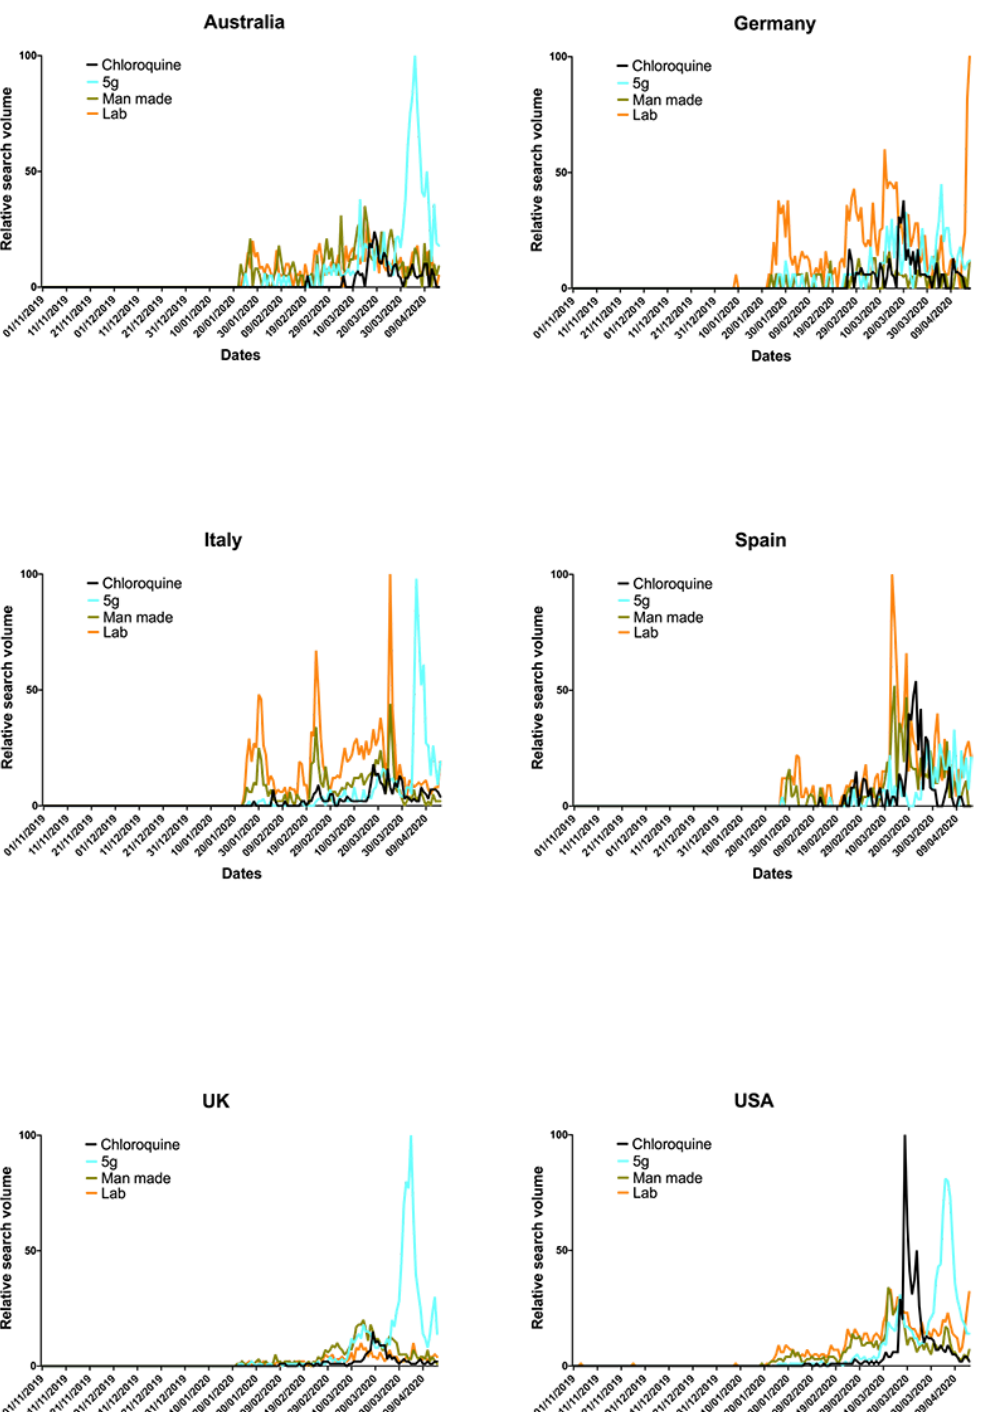
Figure 7. Misinformation relative search volumes (RSVs) extracted from Google Trends (GT). Grouped RSV data, normalized to the highest RSV peak in the time period (represented as 100) were extracted from GT on April 17, 2020, for the period of November 1, 2019, to April 17, 2020. Search terms included “coronavirus chloroquine,” “coronavirus remdesivir,” “coronavirus paracetamol,” “coronavirus vaccine,” and “coronavirus ibuprofen,” with variations to reflect the language native to each